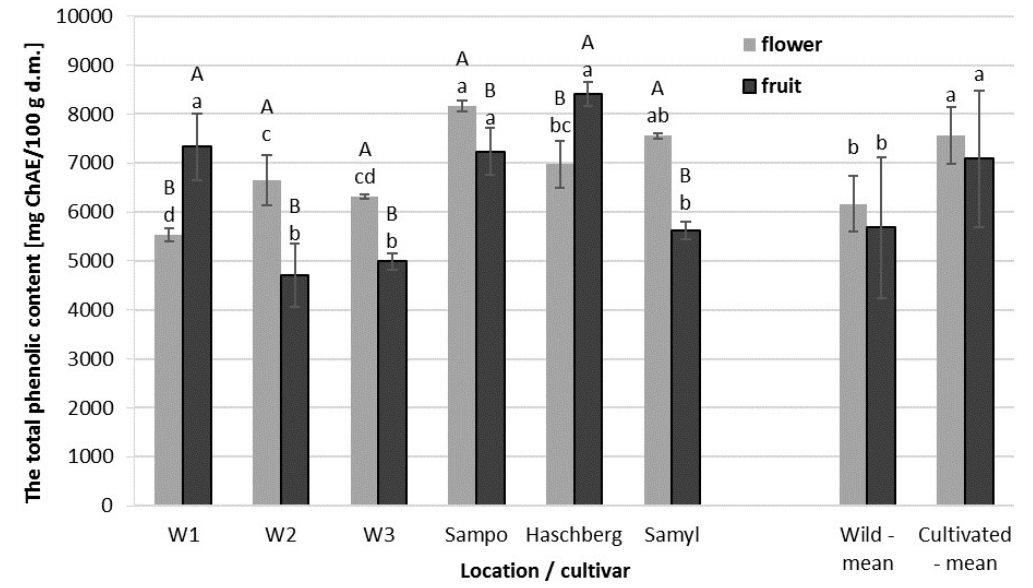
Figure 2. Total phenolic content in elderberry flowers and fruit, depending on location (wild plants) and cultivar. ( A , B ) Differences between flowers and fruit per location (wild plants) and cultivar, and cultivar. ( A , B ) Di ff erences between flowers and fruit per location (wild plants) and cultivar, statistically significant at p < 0.05; (a,b,c,d) differences between flowers or fruit from different statistically significant at p < 0.05; (a,b,c,d) di ff erences between flowers or fruit from di ff erent locations, wild plants and cultivar, statistically significant at p < 0.05. ChAE, chlorogenic acid equivalent.